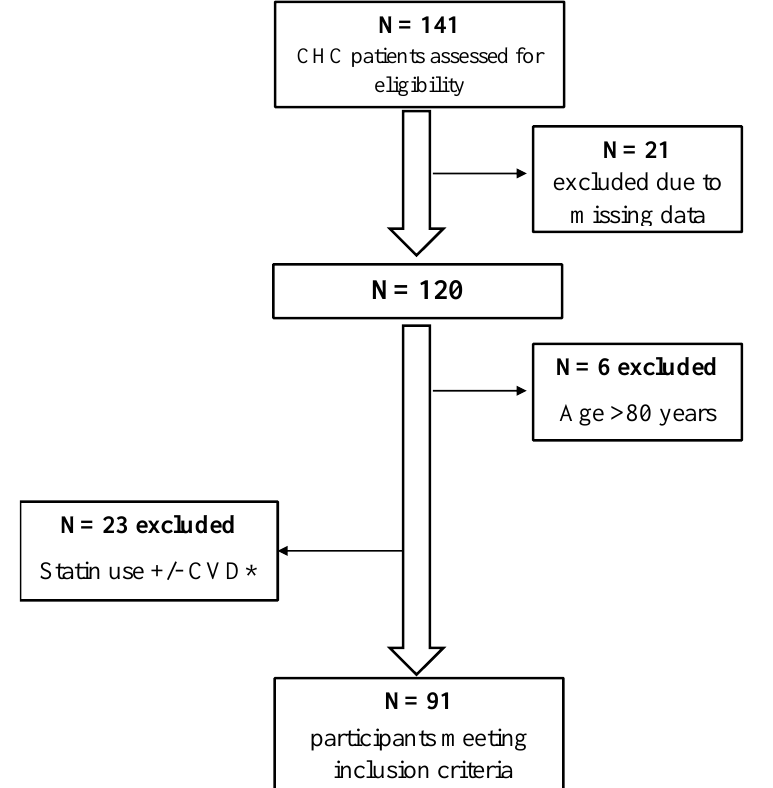
Figure 1. Flow-chart of the study. ACS, acute coronary syndrome; CHC, chronic hepatitis C; CVD, cardiovascular disease; CVA, cerebrovascular accident; * groups not mutually exclusive: N = 7: previous ACS, N = 2: previous CVA, N = 10: cardiac surgery, N = 2: heart failure, N = 7 concurrent statin